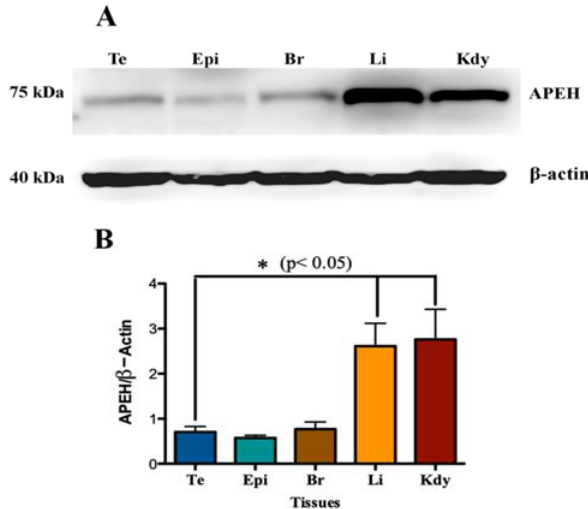
Figure 1. APEH levels in different rat tissues. ( A ) Protein extracts from testis (Te), epididymis (Epi), brain (Br), liver (Li), and kidney (Kdy) were obtained from male rats. Western blot analysis was performed with 30 µ g of each extract, using an anti-APEH antibody. ( B ) Signal intensity of APEH was quantified with Image J and normalized against the signal intensity of β -actin. Each data point represents mean ± SEM of six experiments. Significant differences were found with non-parametric one-way ANOVA (* p < 0.05).